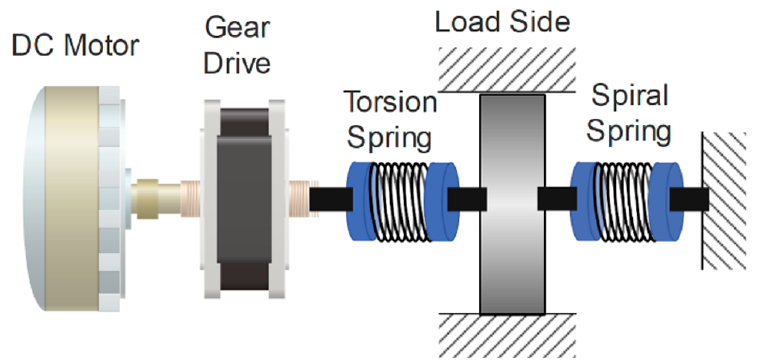
Figure 2. Conceptual design of ES ‐ RSEA .